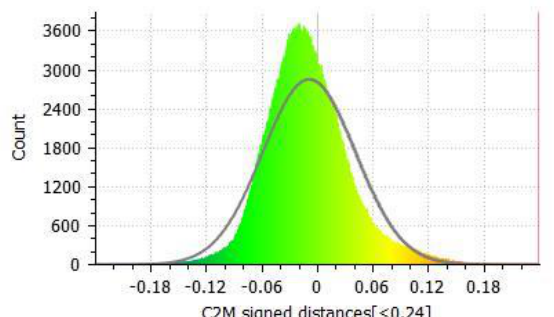
Figure 15. Gauss distribution of the distances without the points near the laser holes